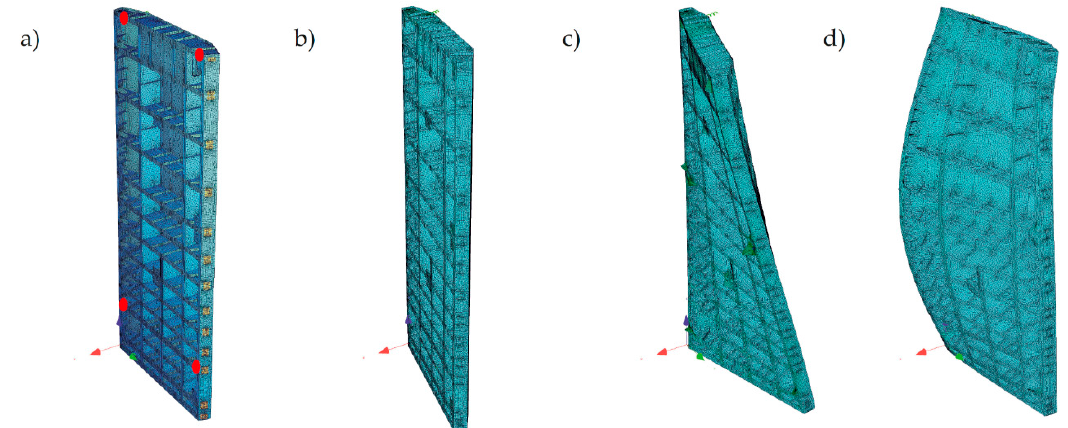
Figure 13. Frequency and eigenforms of the gates’ leaf according to the “opened model”. ( a ) Original geometry; ( b ) First eigenform, f = 0.51 Hz; ( c ) Second eigenform, f = 4.62 Hz; ( d ) Third eigenform, f = 9.46 Hz.